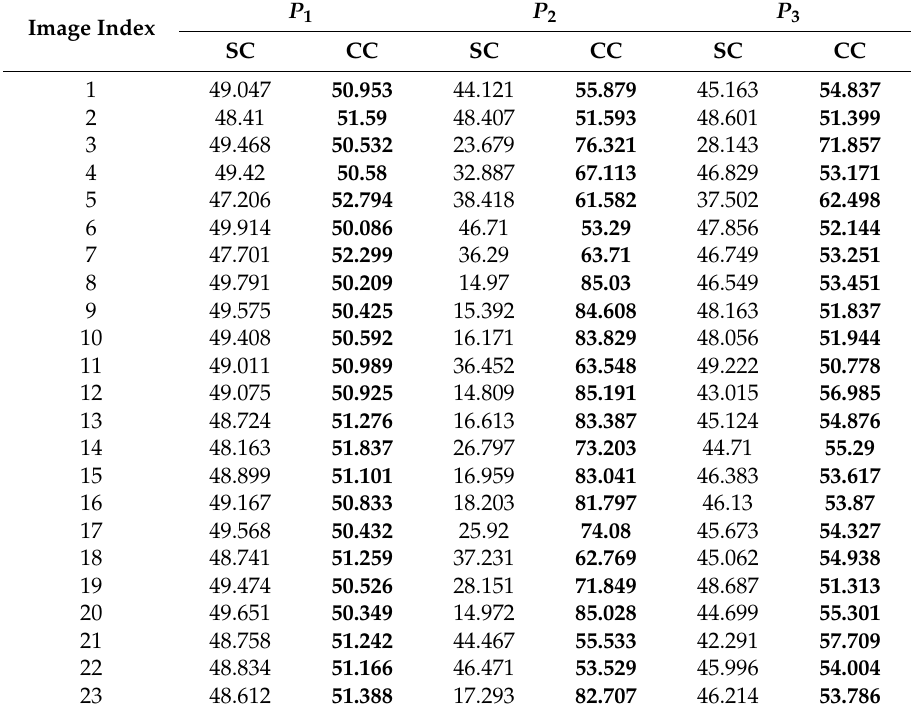
Table 2. The measured P 1 , P 2 , P 3 parameters of SQ images using Hessian matrix.